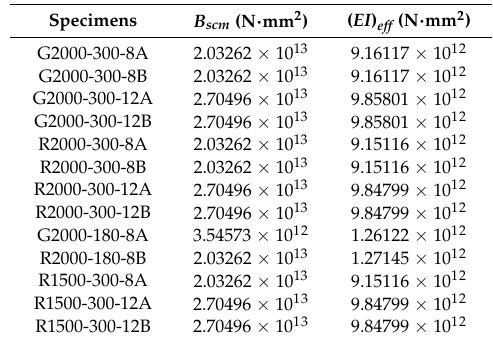
Table 6. Predictions of flexural